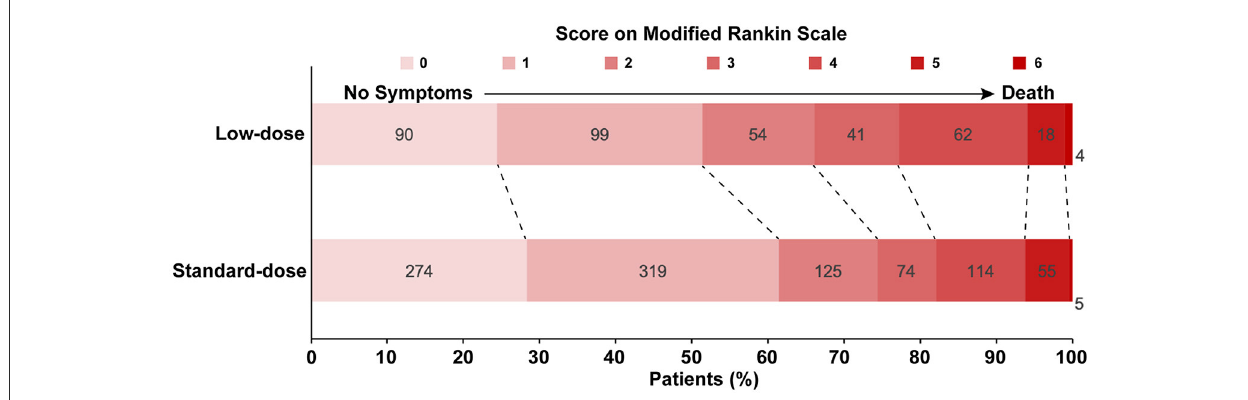
AF, or disability. After adjustment of PSM, 1,334 AIS patients were included in the final analysis. Among them, 368 (27.8%) patients received low-dose alteplase. The median age of the patients